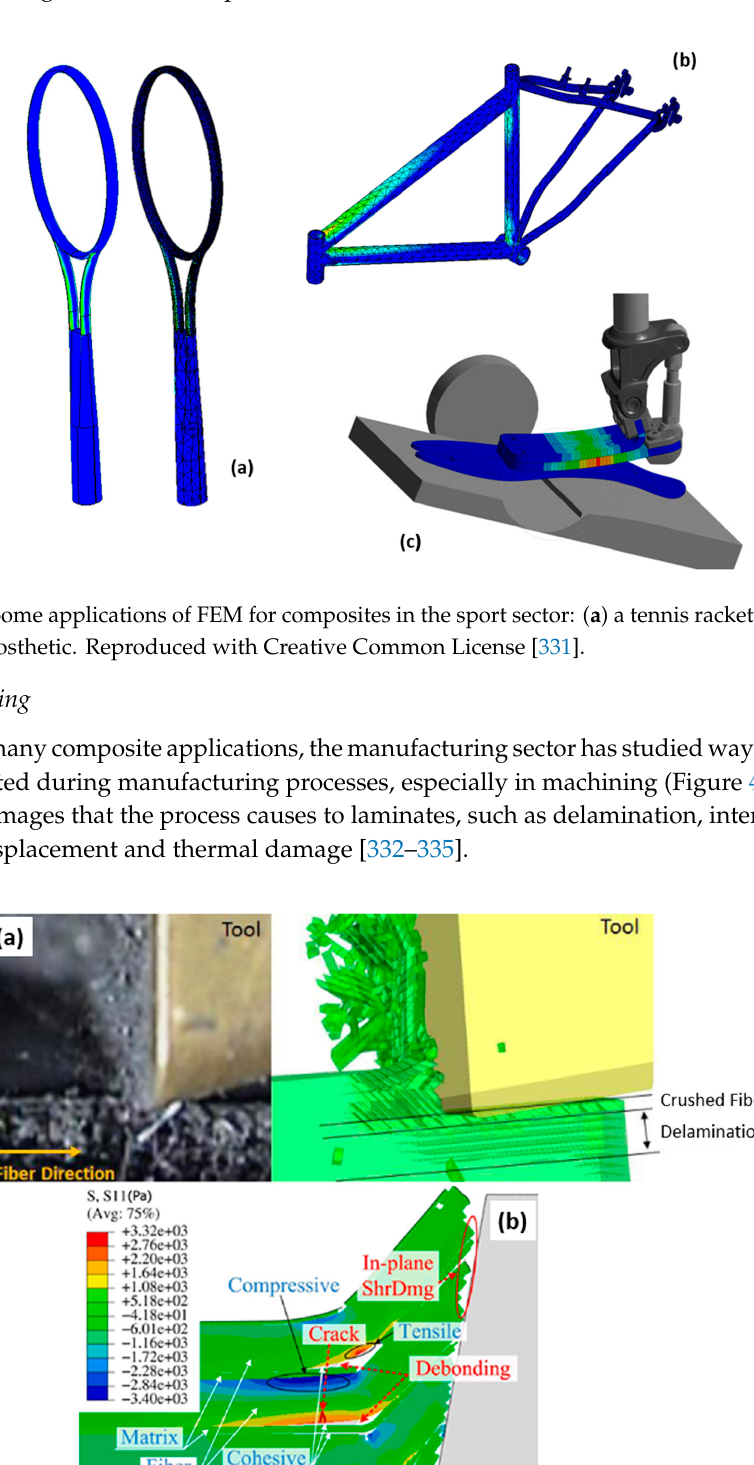
Figure 46. Example of damage cause by machining, (a) Reproduced with Creative Common License [333] and (b) Reproduced with permission [334].